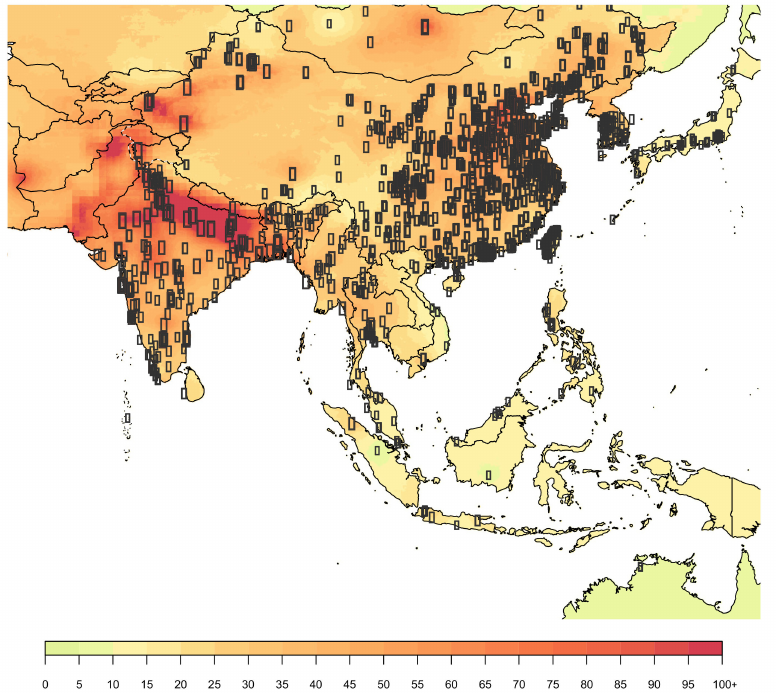
Figure 5. Estimated annual average concentrations of PM 2.5 ( µ g m − 3 ) in the Eastern/South-Eastern Asia and Central/Southern Asia SDG regions for 2016. Estimates are the medians of the posterior distributions from DIMAQ while using the Copernicus Atmosphere Service multi-annual global reanalysis of atmospheric composition.